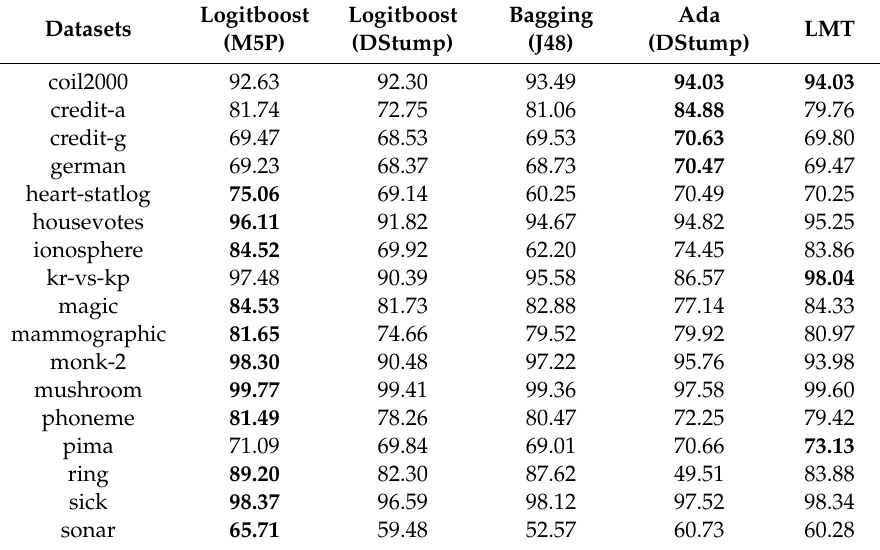
Table 5. Classification accuracy of the Logitboost(M5P) against the selected ensemble base learners for binary datasets under UncS(Ent) strategy with R =